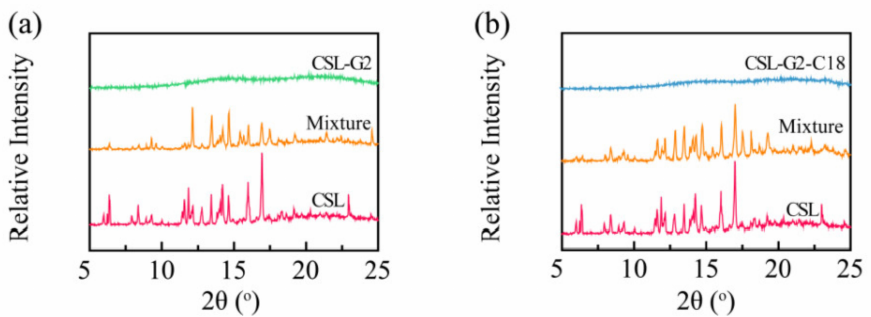
Figure 5. XRD patterns of CSL, CSL-loaded NPs, and the physical mixture of CSL and nanocarriers: G2 series ( a ) and G2-C18 series ( b